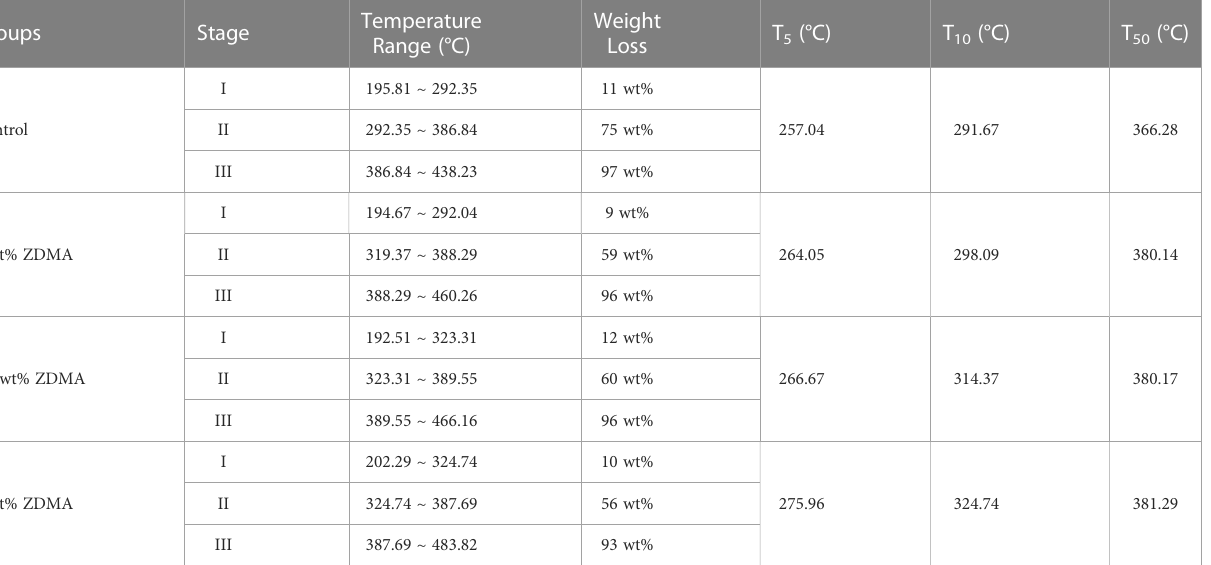
TABLE 1 Comparative study of TGA data for each group.